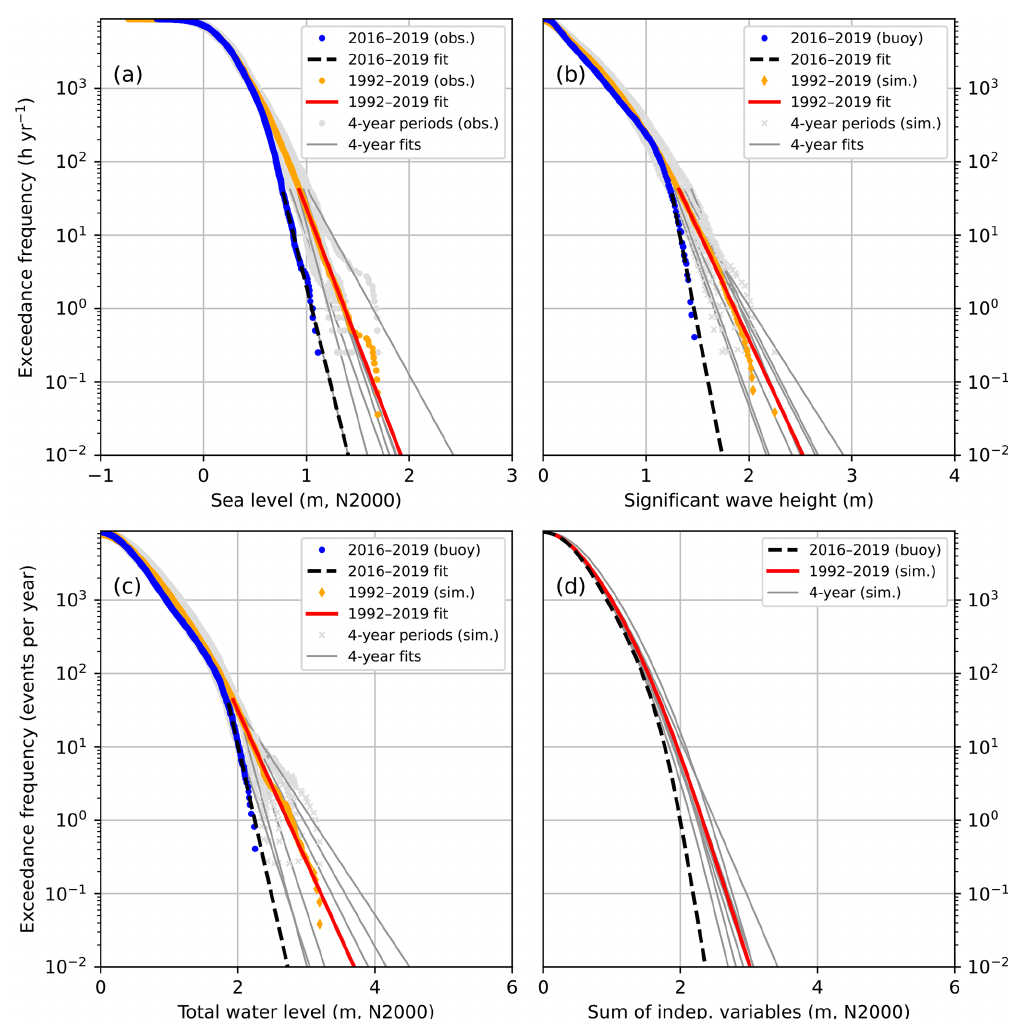
Figure B2. The CCDFs of (a) observed hourly sea levels, (b) observed/simulated significant wave heights, (c) total water level as their sum, and (d) total water level calculated as a sum of two independent variables. The distributions shown are those for the data set N (hypothetical no-ice). The distributions were extrapolated with exponential functions below the exceedance frequency of 44hyr − 1 . The seven consecutive 4-year periods shown separately for observed sea levels and simulated waves are 1992–1995 to